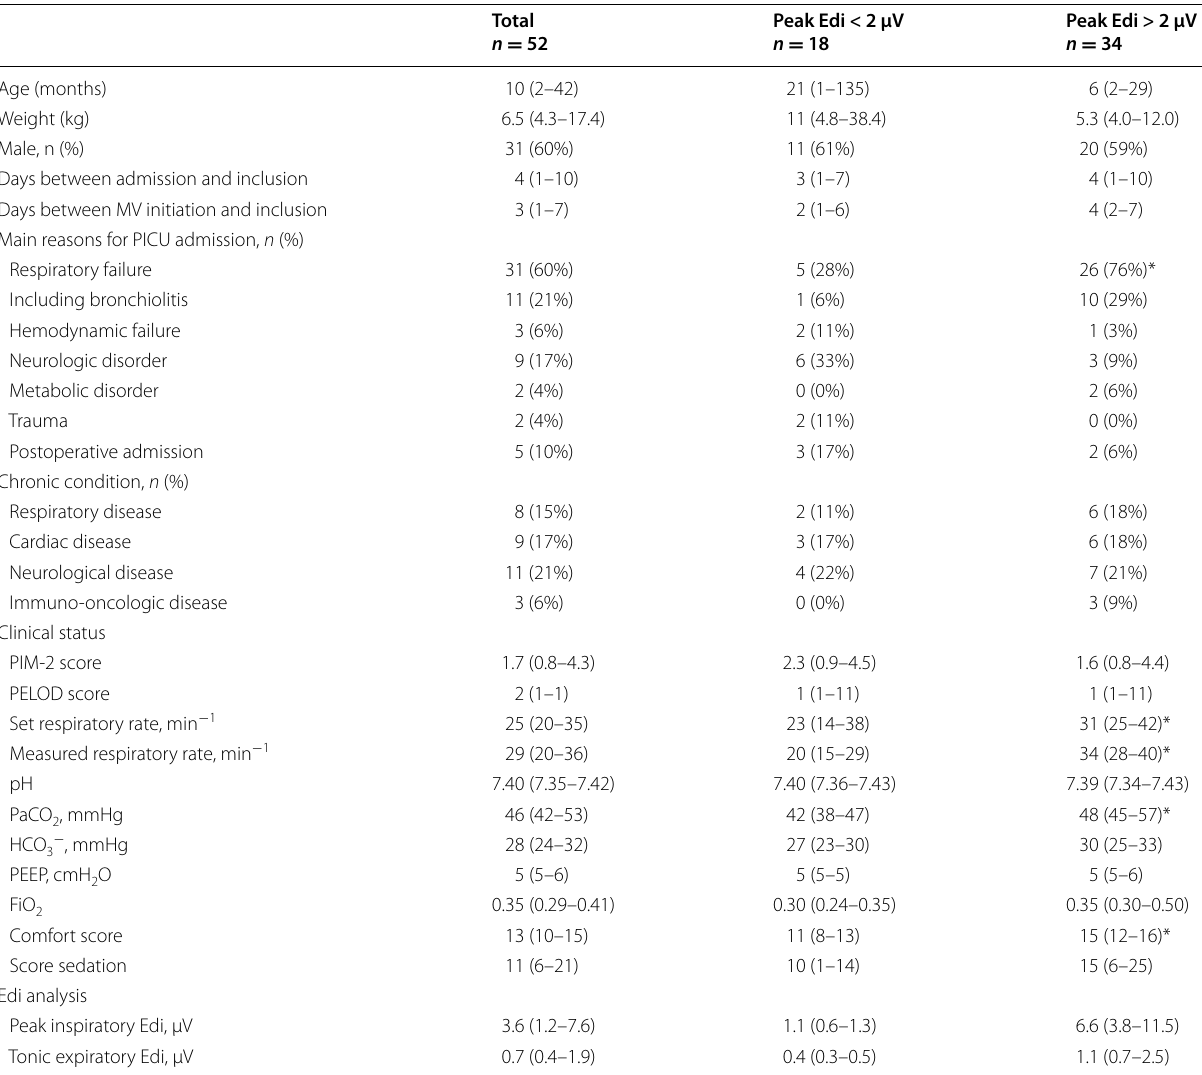
Table 1 Characteristics of population (n